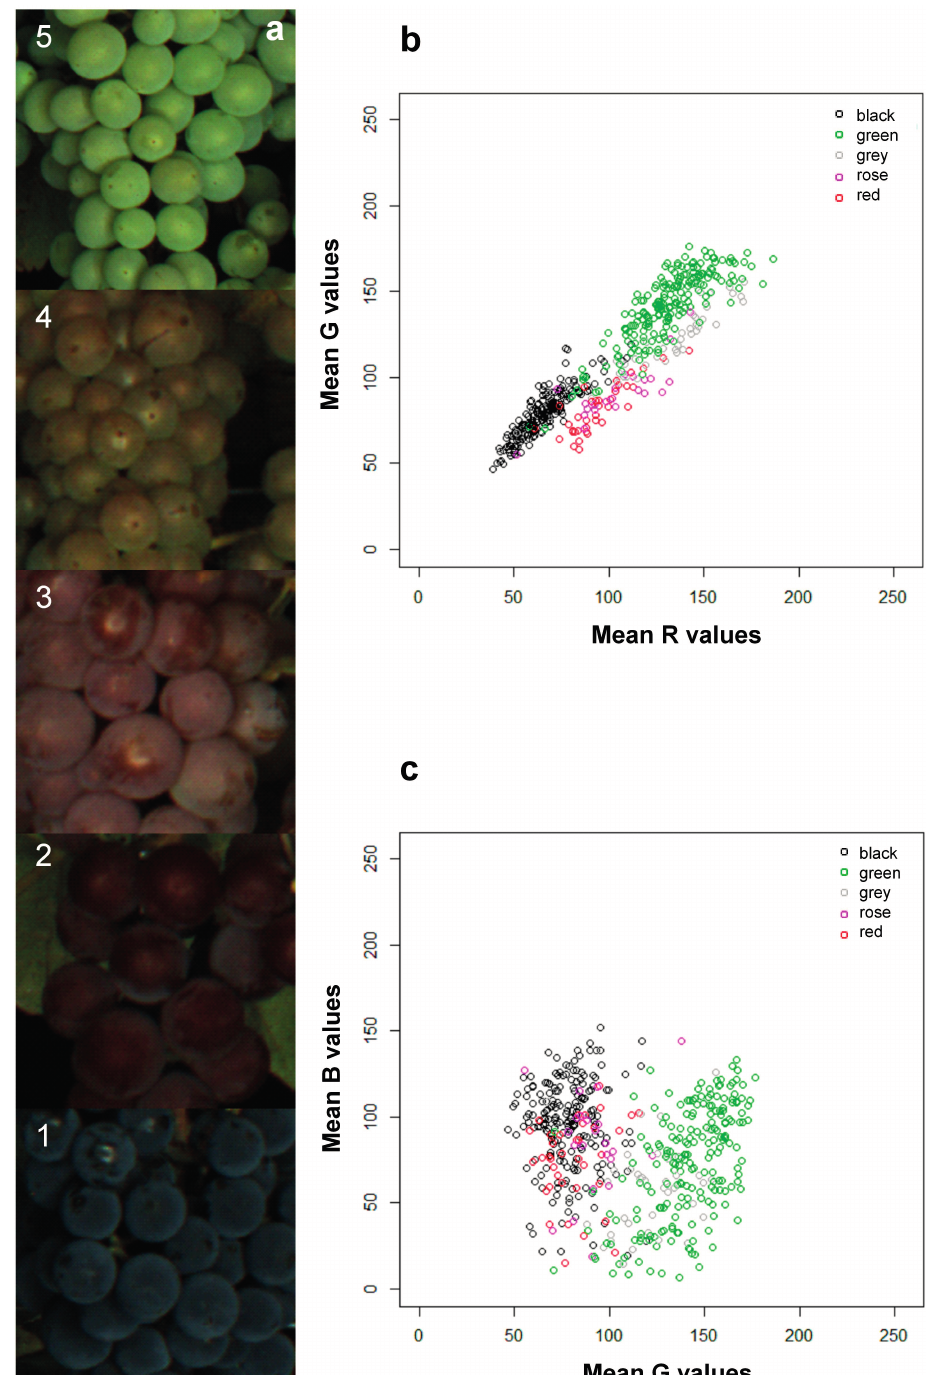
Figure 5. Distance plots of single RGB values indicating the fitness of the color model used for LDA. Prediction of berry color classes was done using the image-based detected RGB values. LDA used three parameters (red, green and blue color values) and, as the ground truth, the visually assessed berry color. ( a ) Berry color was visually assessed as five classes: Class 1 = black; Class 2 = red; Class 3 = rose; Class 4 = grey; Class 5 = green; ( b ) distance plot of R values vs. G values; ( c ) distance plot of G values vs. B